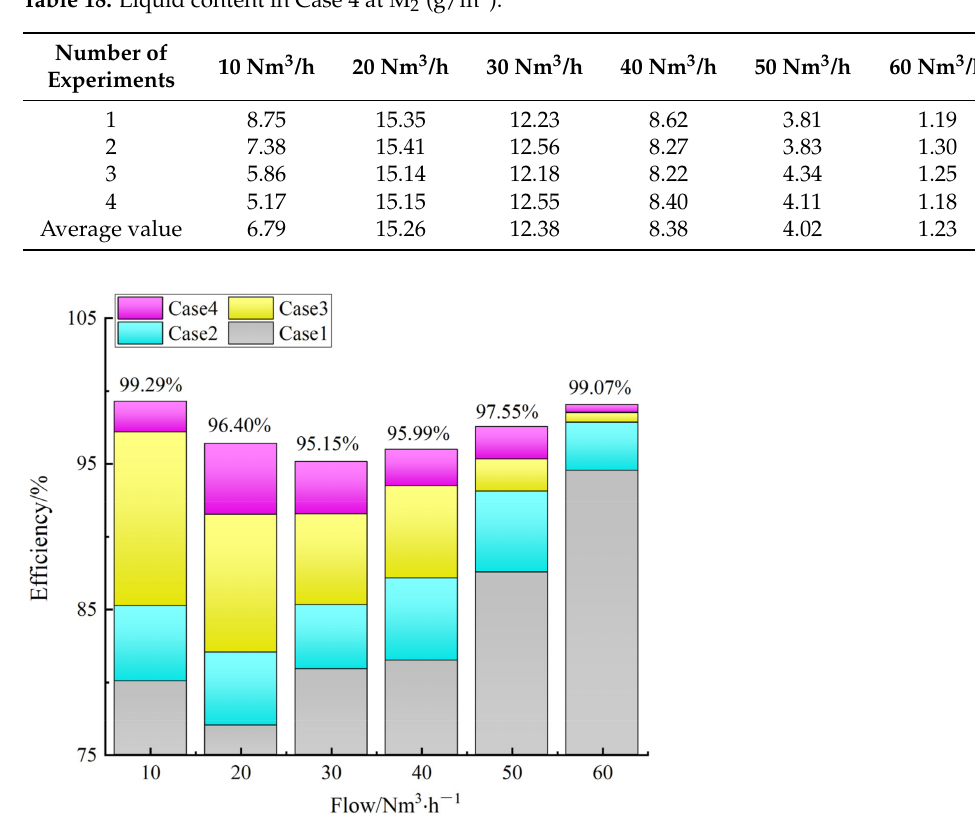
Figure 9. Comparison of the separation efficiency in the four cases.